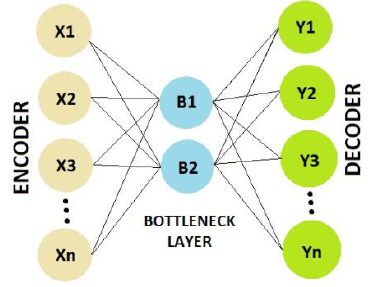
Figure 6. CWT time to frequency domain transformation visualized. ( a ) Presents the normalized X axis of the complementary filter; ( b ) visualizes the result from the CWT algorithm; ( c ) presents the stacked CWT result of each sensor signal.